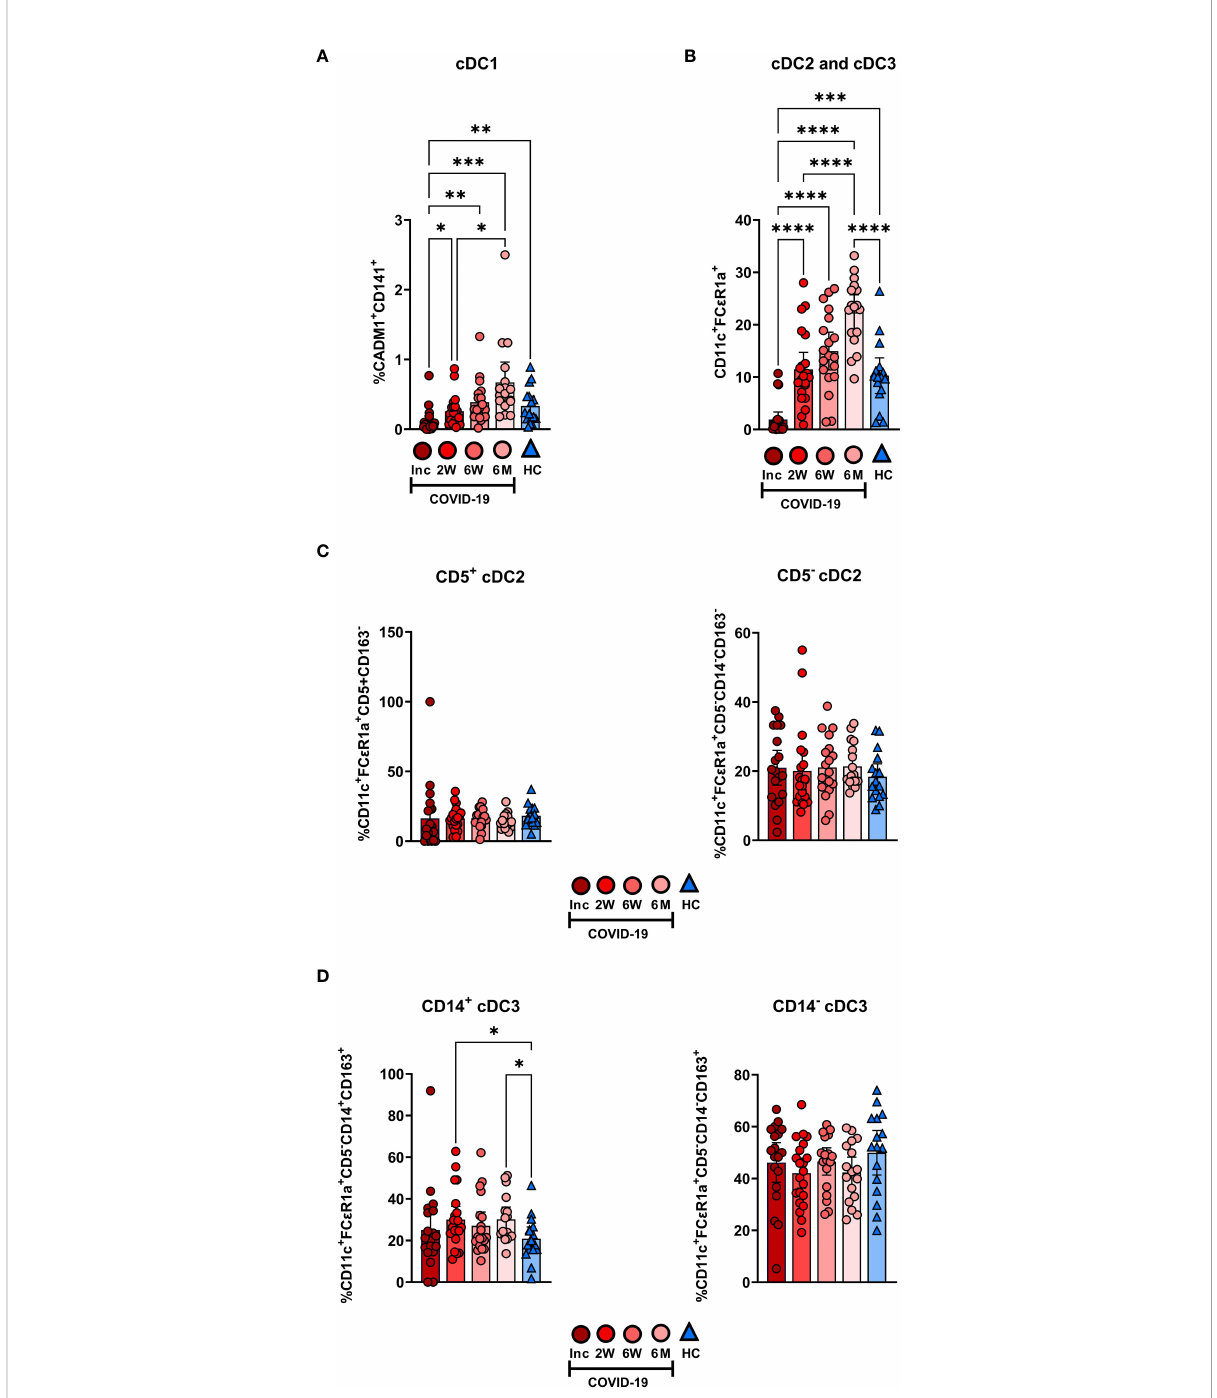
FIGURE 5 Initial depletion of classical DC populations during COVID-19. PBMCs from hospitalized COVID-19 patients (N = 21) and healthy donors (N = 16), were stained for fl ow cytometry to observe changes in the composition of the cDC compartment during COVID-19. Proportions of (A) CADM1 + CD141 + cDC1, (B) CD11c + FC ϵ R1a + cDC2 and cDC3 combined, (C) CD5 + CD163 - cDC2 and CD5 - CD163 - cDC2, and (D) CD5 - CD14 + CD163 + cDC3 and CD5 - CD14 + CD163 + cDC3 are shown. Data is presented as mean with 95% Cl, with signi fi cance of *p ≤ 0.05, **p ≤ 0.01, ***p ≤ 0.001, ****p ≤ 0.0001, determined using Brown-Forsythe and Welch ANOVA tests. Inc, Study inclusion; 2W, 2 weeks; 6W, 6 weeks; 6M, 6-7 months; HC, healthy